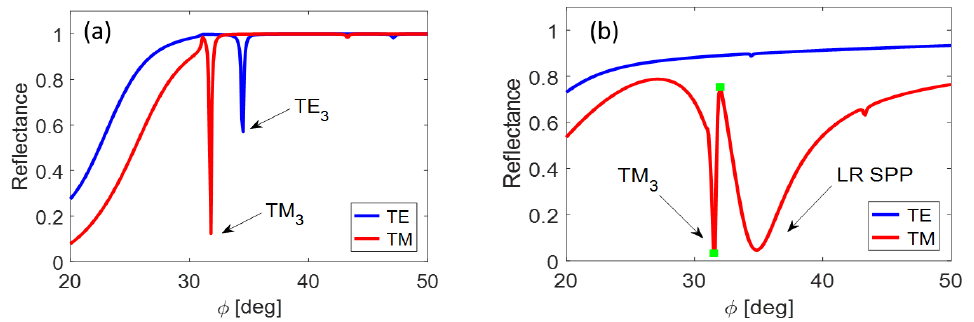
Figure 9. Mutual coupling of the TM 3 waveguide mode and the long-range plasmonic mode: ( a ) layer thicknesses 0/140/0/170/470/100 (WG modes only); and ( b ) layer thicknesses 34/140/10/170/470/100 (coupled resonance states).